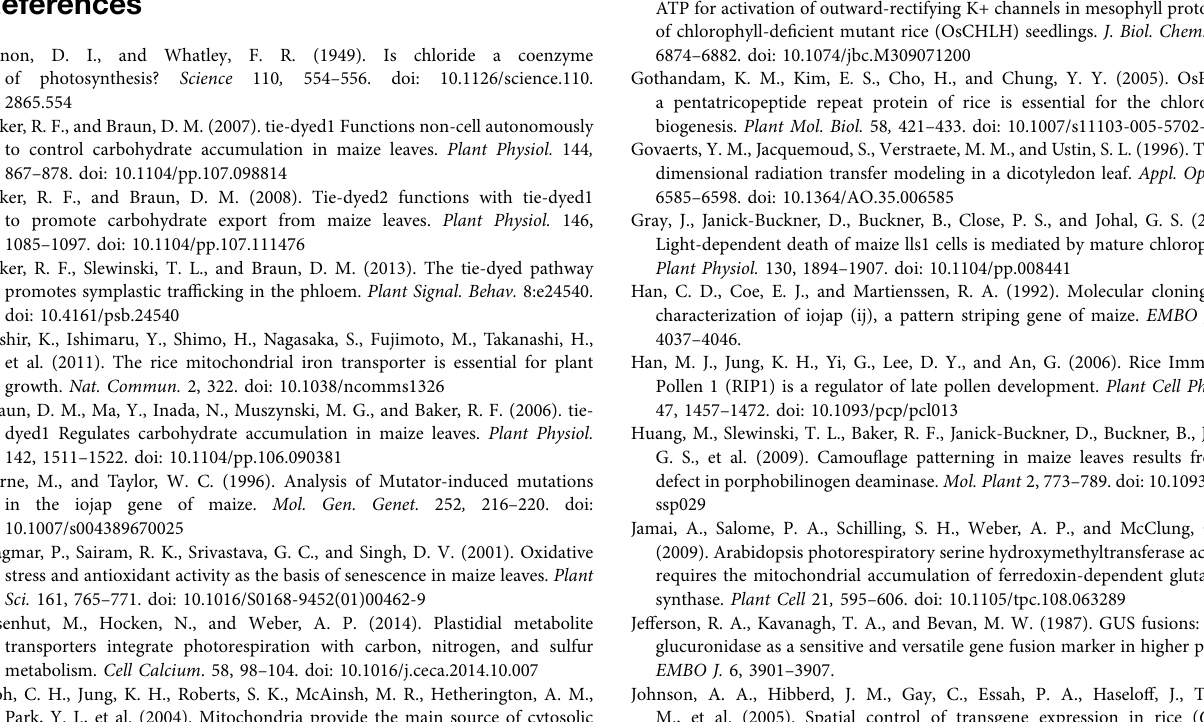
left border of the T-DNA; RB, right border of the T-DNA. Additional key functional elements are shown in this map. − 48CaMV, which was activated by chromosomal enhancer elements, is a minimal CaMV 35S promoter. GAL 4/ Vp 16 is a modified gene composed of the yeast transcriptional activator GAL4 DNA-binding domain and herpes simplex virus VP 16 activation domain, fused to the minimal promoter –48CaMV. The reporter gene is also a fused gene containing BoGUS and EGFP. 6 × UAS, an upstream activator sequence with six repeats, was located in front of the reporter gene. Figure S2 | Sequence alignment of SHMT homologs from soybean, rice, and Arabidopsis . Identical residues are boxed in black; similar residues are highlighted in gray. The pyridoxal phosphate binding site is marked using a red line. The OsSHMT1 SHMT domain spans residues 51–449. Figure S3 | BN gel analysis of thylakoid membrane protein complexes. Lane l, wild type; lane 2, oscdm1 . Band I, PSI monomer and PSII dimer; II, ATP Figure S4 | A phylogenetic tree showing the predicted relationships among soybean, rice, and Arabidopsis . The full-length amino acid sequences of each protein were aligned using CLUSTALW and revised manually. The tree was constructed using the neighbor-joining method with full-length protein sequences from soybean, rice, and Arabidopsis . The results indicate that the SHMT protein sequences were divided into three subfamilies: SUBI [ Oryza sativa : OsSHMT1 and OsSHMT3; soybean: GmSHMT1 and GmSHMT4; and Arabidopsis : AtSHMT3, AtSHMT4, and AtSHMT5]; SUBII [ Oryza sativa : OsSHMT2 and OsSHMT4; soybean: GmSHMT3 and GmSHMT5; and Arabidopsis : AtSHMT1 and AtSHMT2]; and SUBIII [ Oryza sativa : OsSHMT5; soybean: GmSHMT2; and Arabidopsis : AtSHMT6 and AtSHMT7]. The bar represents the genetic distance in the phylogenetic tree. Figure S5 | Transmission electron microscopic images of mitochondria from 1-month-old wild-type and oscdm1 mutant plants. (A) A wild-type plant. (B) An oscdm1 plant. The wild-type mitochondrial membranes were well-ordered, while the mutant mitochondrial membranes were abnormal and became irregular. Bar = 100nm. Table S1 | Primer sequence for